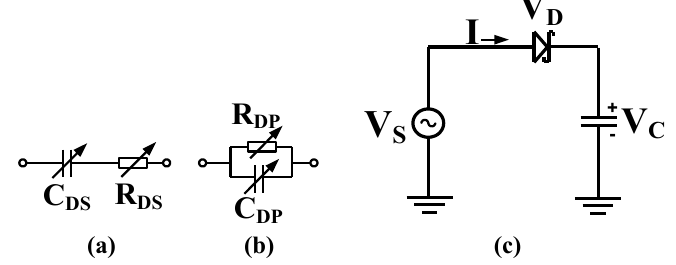
Figure 1. ( a ) Diode series equivalent model, ( b ) Diode parallel equivalent model, ( c ) Simple diode